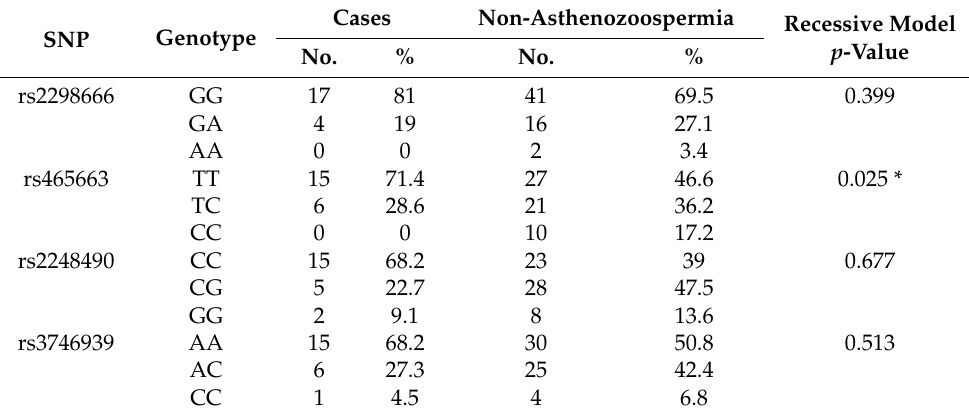
Table 3. Associations between genetic variants of the WDR4 gene and asthenozoospermia.